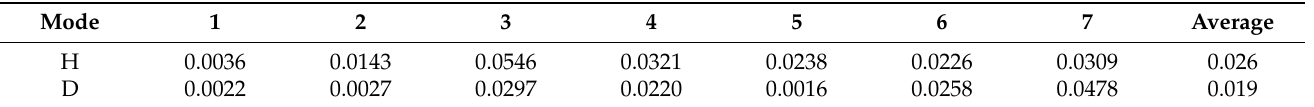
Table 5. MFC material properties provided by Smart Materials [36].